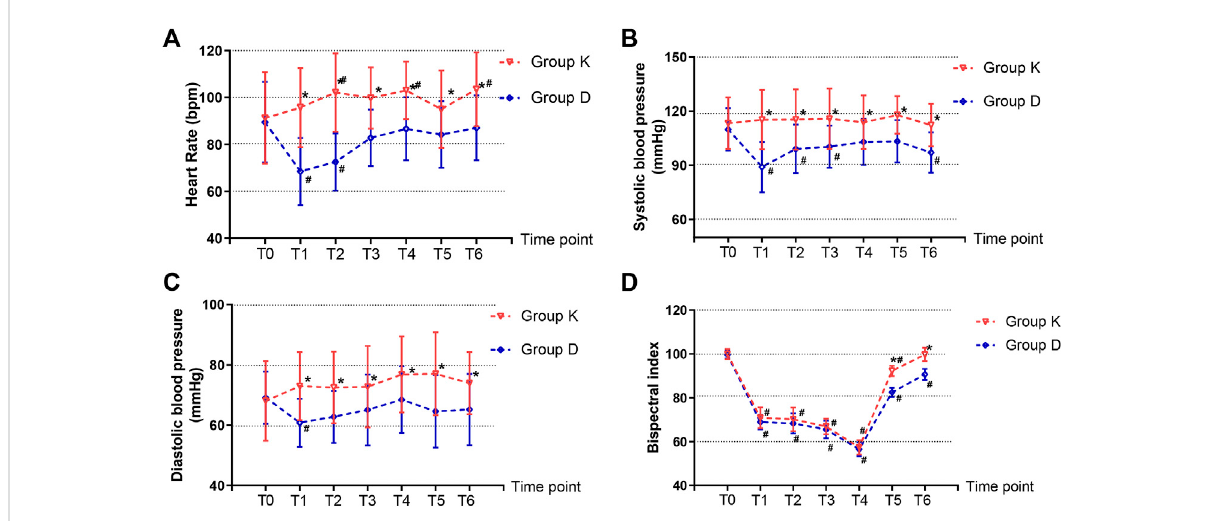
FIGURE 2 Hemodynamicchanges andthebispectral index(BIS)records. (A) Heartrate (HR). (B) Systolicbloodpressure(SBP). (C) Diastolic bloodpressure (DBP). (D) The bispectral index (BIS). Data are expressed as mean ± SD, Compare between two groups * p < 0.05. Compare within time points of the same group # p <